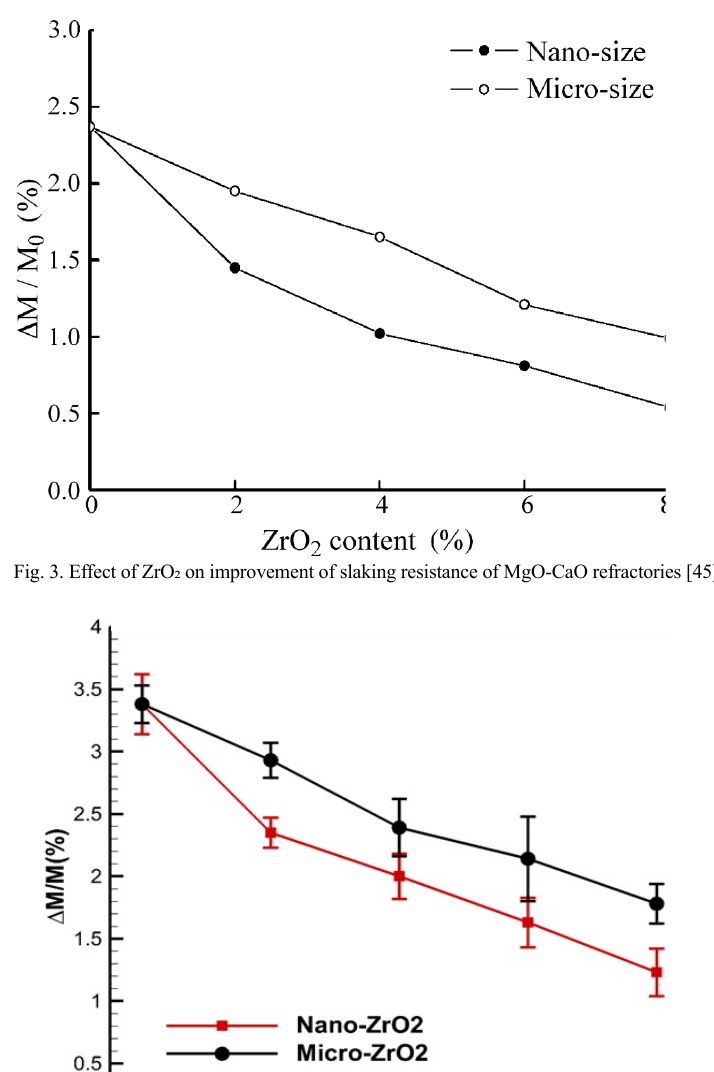
Fig. 4 The effect of nano and micro ZrO 2 addition on improvement of the Fig. 4. The effect of nano and micro ZrO addition on improvement of the hydration resistance of the MgO-CaO refractories 2 hydration resistance of the MgO-CaO refractories [21].